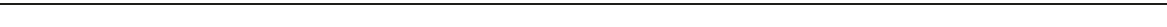
Fig. 6 Identi fi cation of host kinases controlling intracellular Mtb survival. a STRING network of con fi rmed targets of dovitinib retrieved from the ChEMBL repository Compound Bioactivity section (left panel). Individual proteins are displayed as nodes. Lines represent protein – protein interactions and the thickness of the lines indicates con fi dence. Proteins participating in the “ transmembrane receptor tyrosine kinase signaling pathway ” are displayed in red. The top 10 enriched GO terms in the “ Biological Function ” category are displayed along with the number of genes/proteins annotated with the indicated GO terms and the false-discovery rate (FDR) of the enrichment (right panel). b Results of a siRNA screen of the human kinome in the MelJuSo- Mtb infection model using Mtb constitutively expressing destabilized DsRed, expressed as z -scores. The average z -score ± standard deviation for each siRNA pool is displayed. A hit cutoff at z = 2 or z = – 2 is displayed as a dashed line. The average z -score and standard deviation of the controls (siCTRL and siAKT) are displayed separately. SiCTRL: nontargeting siRNA pool. c STRING network of the siRNA screen hits (left panel) is displayed along the top 10 enriched GO terms in the “ Biological Function ” category (right panel), as in a . d Participation of individual targets of dovitinib (top row) or hits from the siRNA screen (bottom row) in the “ transmembrane receptor tyrosine kinase signaling pathway ” are indicated by fi lled squares. Proteins that are both targeted by